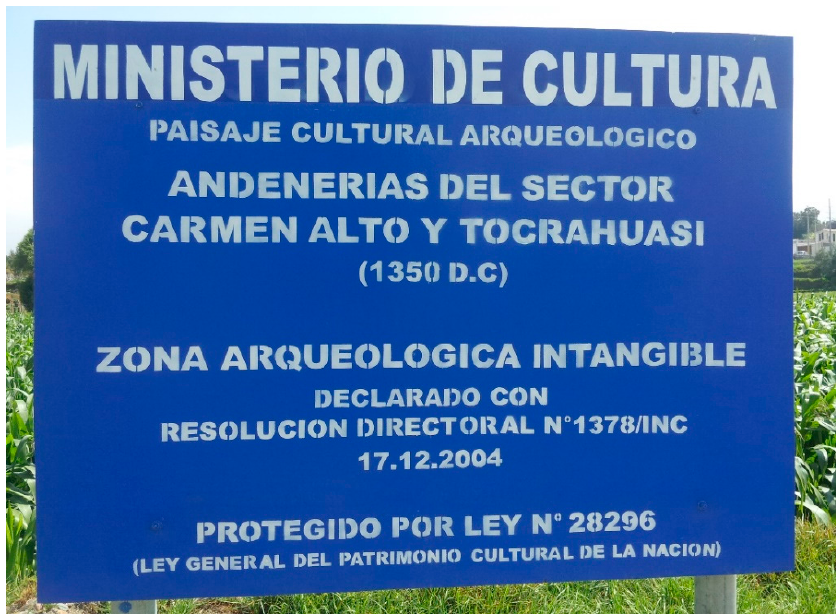
Figure 8. One of the many signs all over Carmen Alto legally protecting its bucolic view. February 2018.